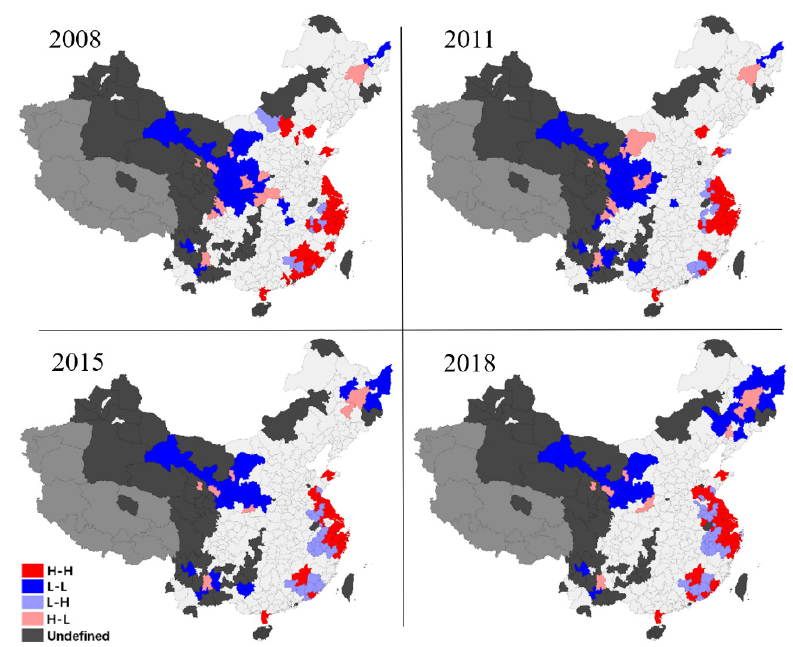
Figure 6. Regional Evolution of spatial patterns of the digital economy.